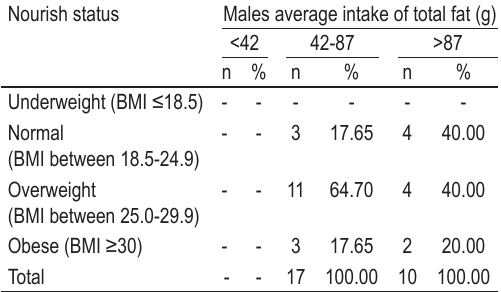
FIGURE 1. Link between BMI and total fat intake in male students